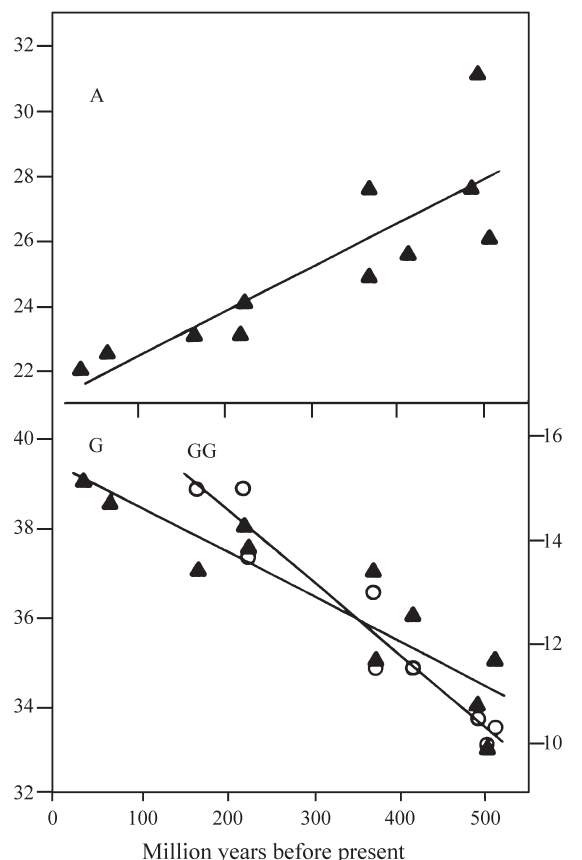
Figure 3 - Trends in purine base composition and in guanine dinucleotide frequency in the 5S rRNA of deuterostomes. Linear regression of group averages vs. paleontologydating.Dinucleotidedatabeyondsquamatesnot utilized,duetohavingbecomeconstant(seeFigure1).A=21.070+0.013 x, r = 0.848; G ( (cid:1) , left ordinate) = 39.453 - 0.010 x, r = -0.904; GG ( (cid:1) , right ordinate) = 17.521 - 0.014 x, r = -0.966.